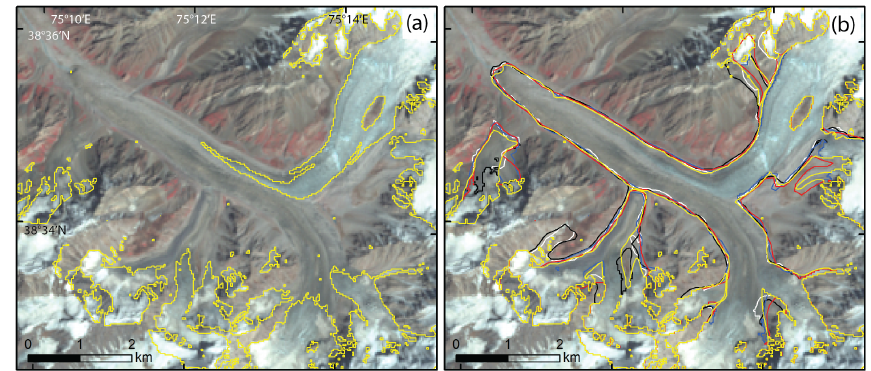
Figure 14. Results of the expert round robin, example Glacier 2. (a) shows mapping results solely based on the satellite image, whereas (b) shows mapping results after manual corrections using the additional source of coherence images and Google Earth high-resolution imagery.